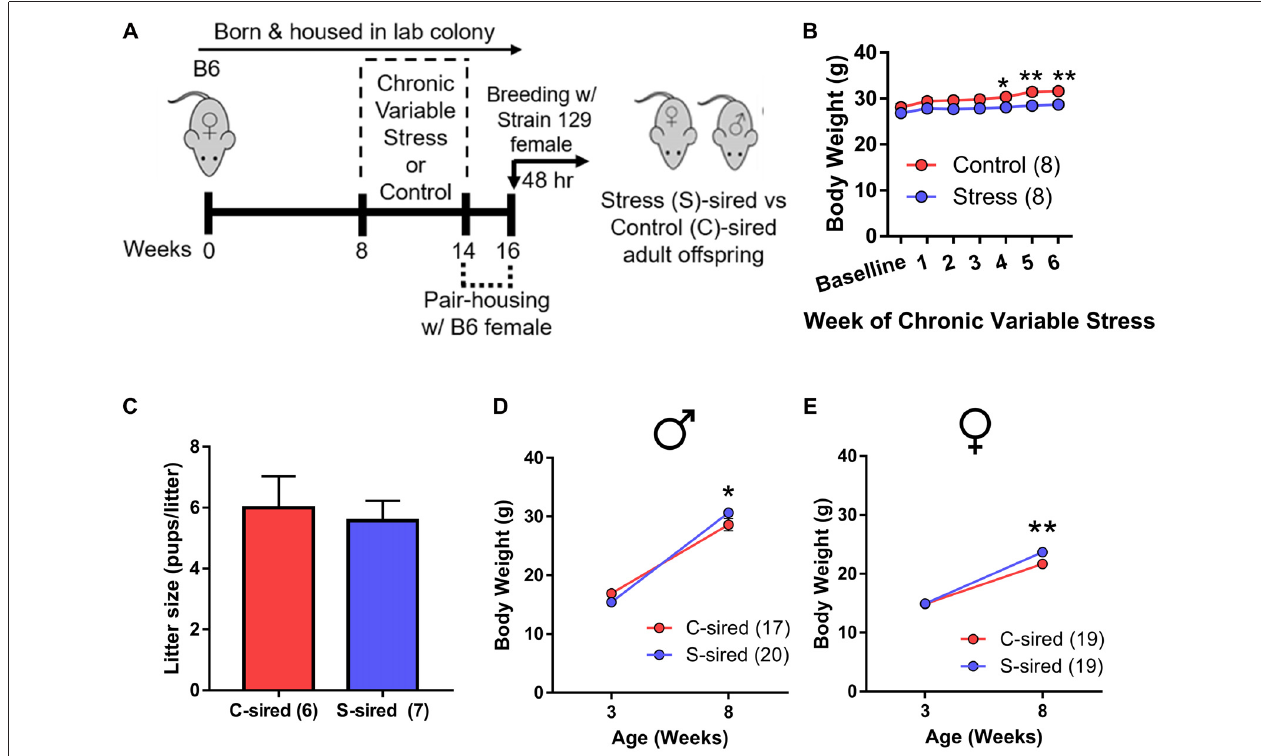
FIGURE 1 | Intergenerational effects of paternal preconception chronic stress. (A) Experimental timeline. Eight-week-old male mice were exposed to 6 weeks of chronic variable stress or control conditions. Two weeks after chronic variable stress or control conditions, males were bred with stress-naïve Strain 129 females for two nights to produce male and female stress (S)-sired and control (C)-sired offspring. (B) Significantly reduced body weights in S-sires vs. C-sires ( N = 8/group). (C) No effect of paternal stress on litter sizes ( N = 6–7/group). (D) Increased body weight at 8 weeks postnatal in S-sired vs. C-sired male offspring ( N = 17–20/group). (E) Increased body weight at 8 weeks postnatal in S-sired vs. C-sired female offspring ( N = 19/group). ∗ p < 0.05, ∗∗ p < 0.01. Error bars in panels (B,D,E) are obscured by symbols.